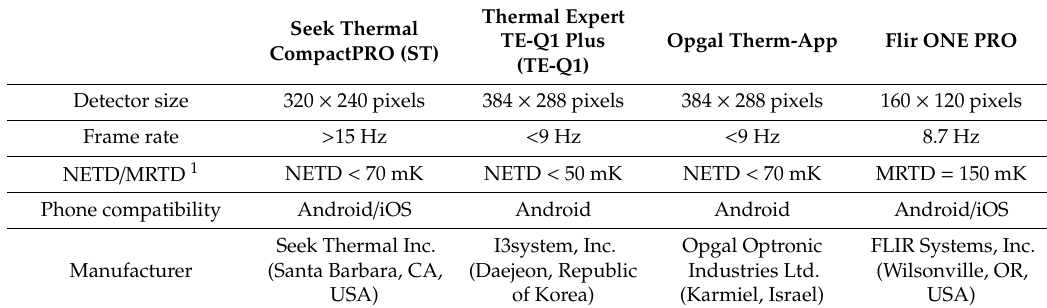
Table 1. Characteristics of low-cost commercially available long-wavelength infrared (LWIR) cameras as provided by their manufacturers.